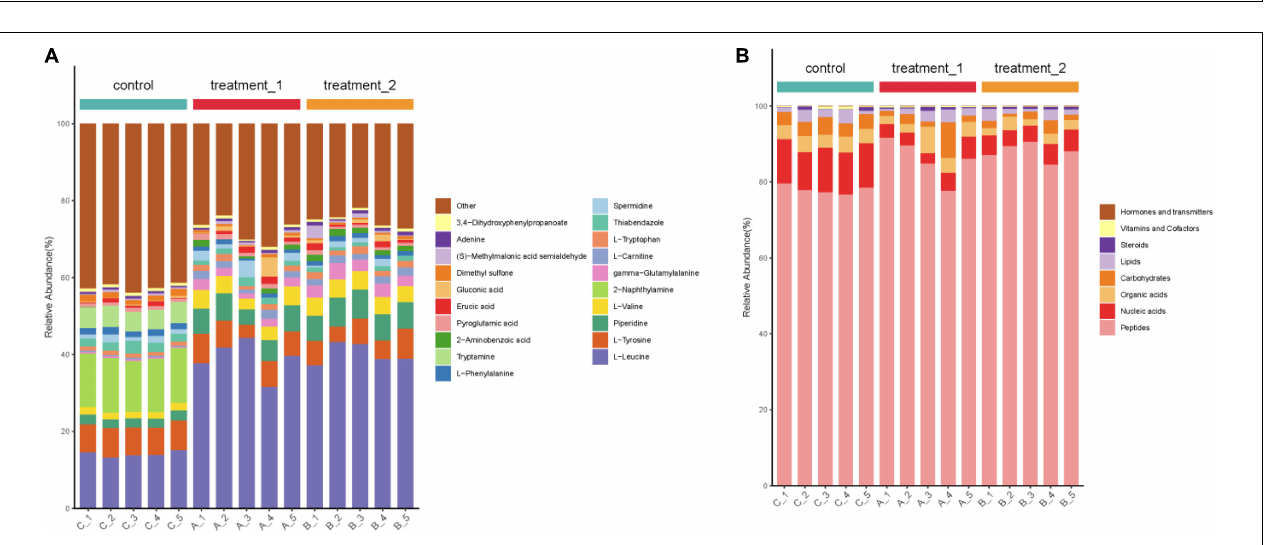
FIGURE 6 | Hierarchical cluster analysis heat map. The concentration of 10 mg/L OFL is treatment 1; and the concentration of 5 mg/L OFL is treatment 2; Control does not add OFL.